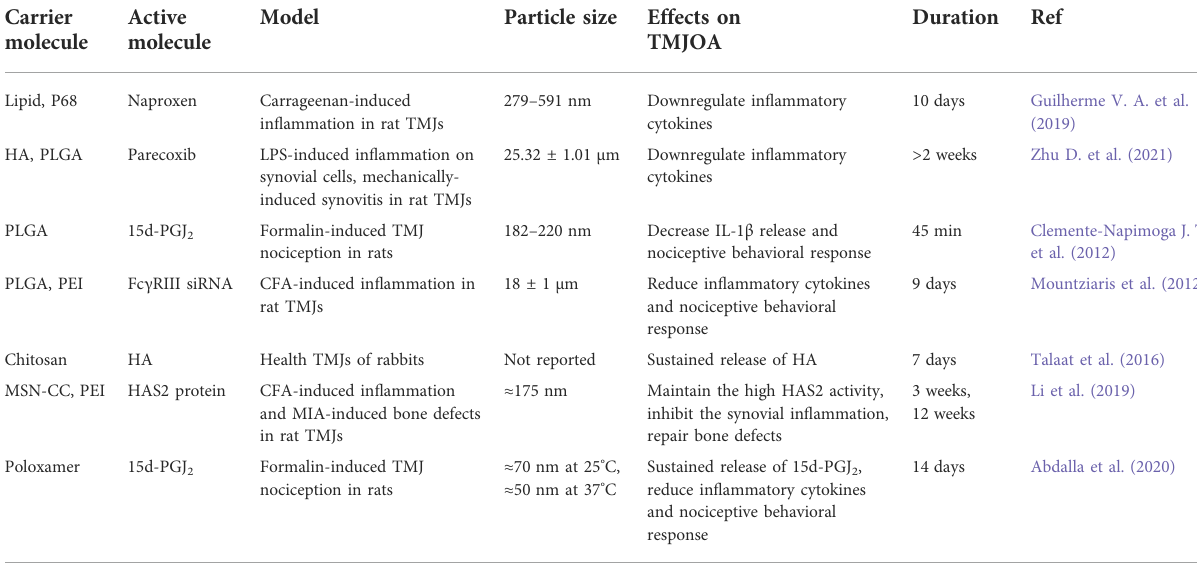
TABLE 1 Different drug delivery systems for intra-articular injection. Carrier